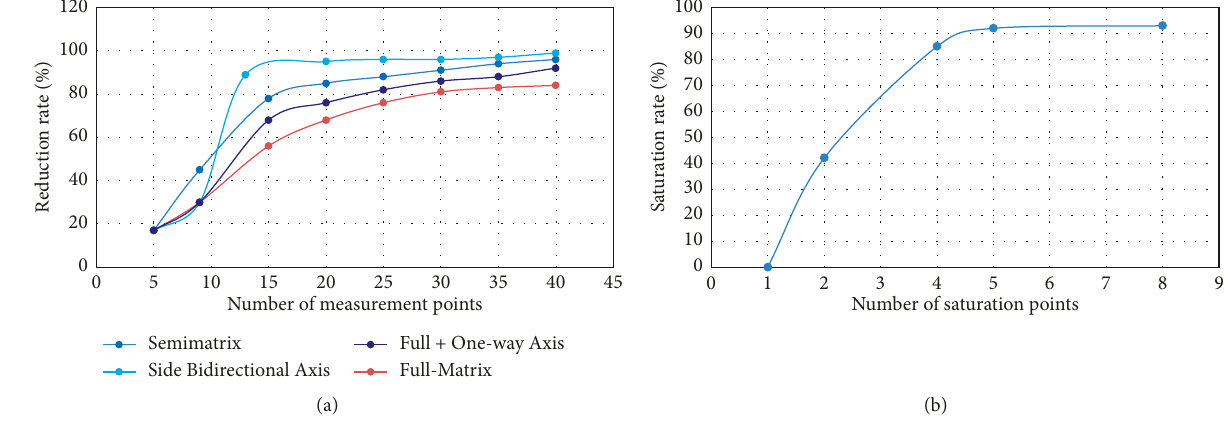
Figure 3: Optimization of (a) measurement points and (b) saturation